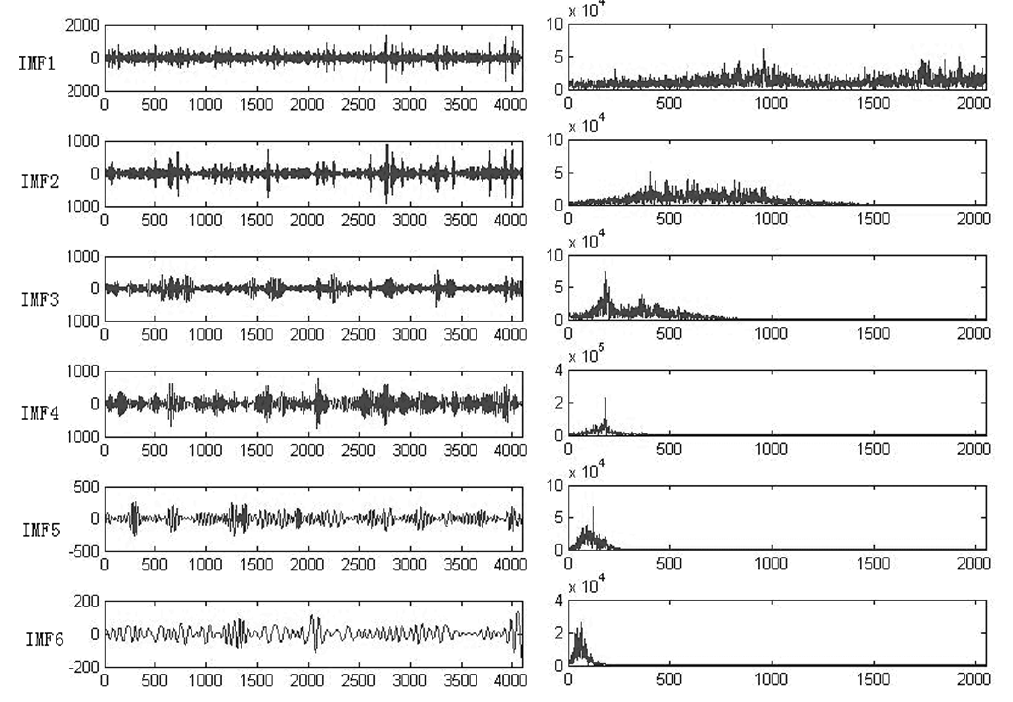
Fig. 2. First six level IMF and spectrum of a crack fault signal at 300 rpm.